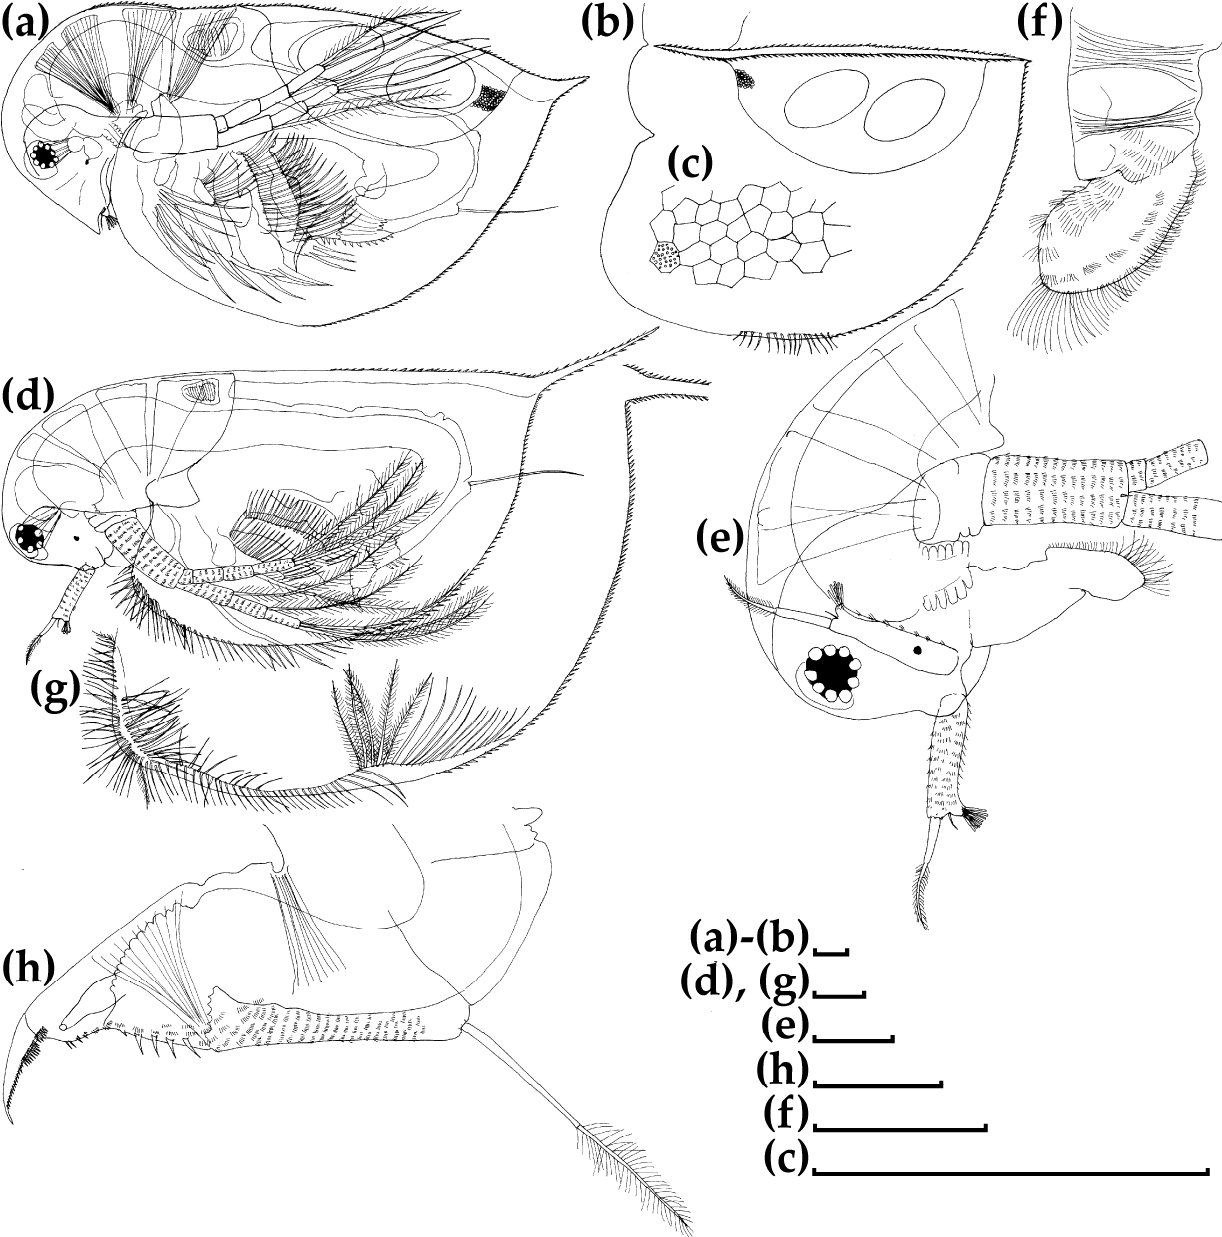
Figure 6. Daphnia arabica sp. nov., an ephippial female ( a – c ) and adult male ( d – h ) from Al Shuwaib Dam, near Al Ain city, United Arab Emirates, paratypes. ( a ) Ephippial female, lateral view. ( b ) Ephippium, lateral view. ( c ) Ornamentation of ephippium under higher magnification. ( d ) Male, lateral view. ( e ) Head. ( f ) Labrum. ( g ) Valve. ( h ) Postabdomen. All scale bars are 0.1 mm.